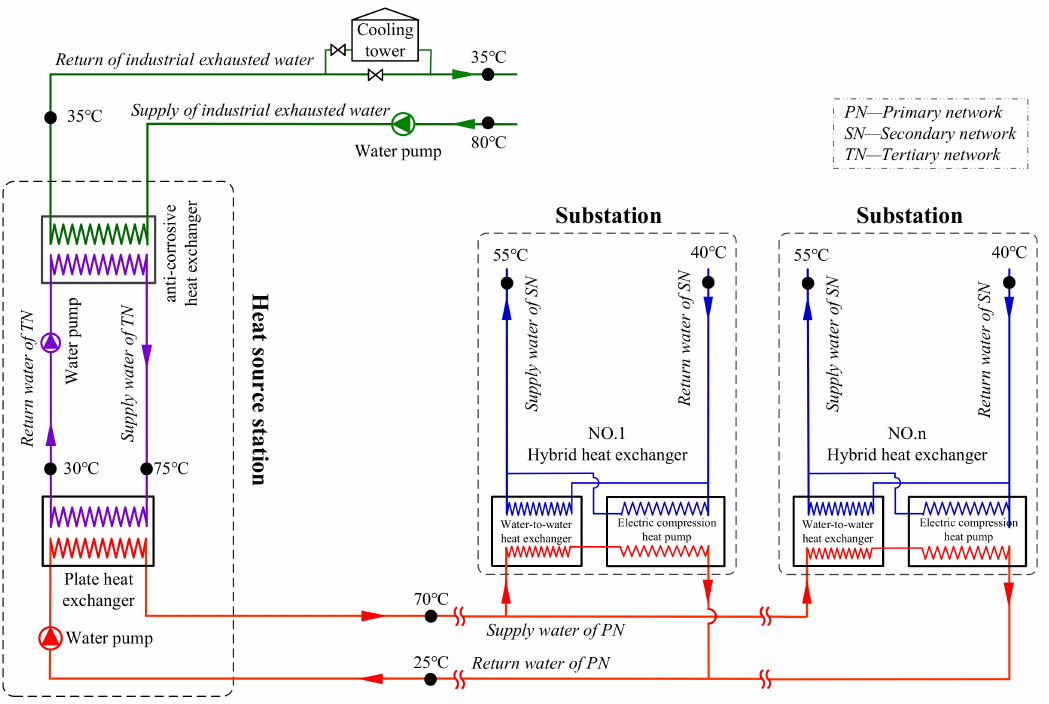
Figure 2. Sketch of central heating system integrated with industrial exhausted heat using distributed electric compression heat pumps (CH-DHP).